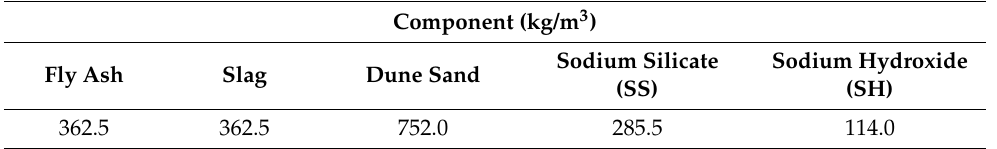
Table 4. Geopolymeric matrix components and